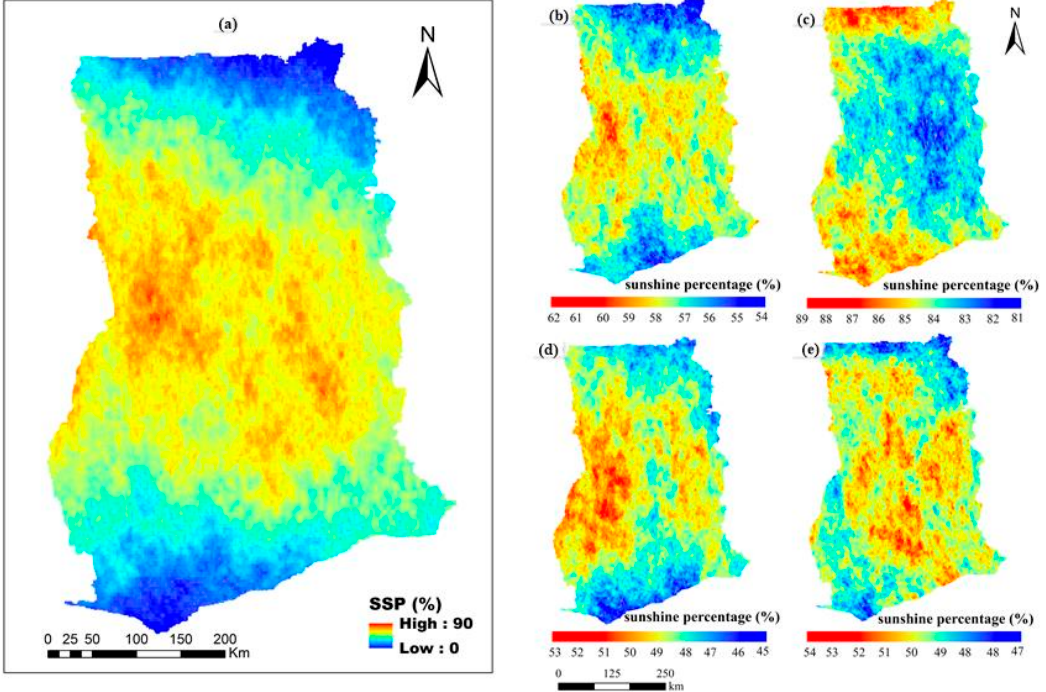
Figure 1. Sunshine Percentage (SSP) for ( a ) whole year, ( b ) January, ( c ) April, ( d ) July and ( e ) October, 2010. High SSP values indicate months with more days of sunshine and low SSP values indicate months with fewer sunny days.